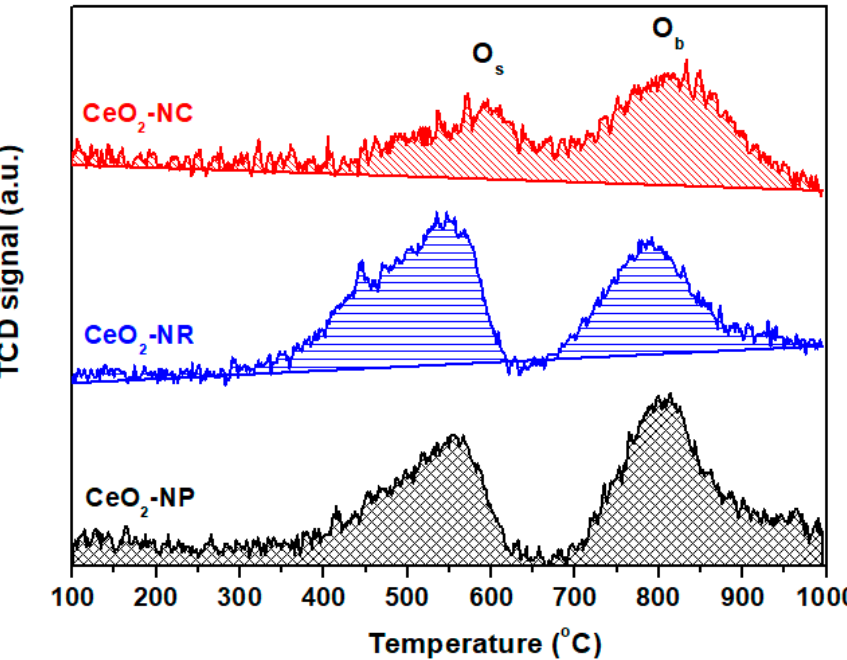
Figure 4. H 2 -TPR profiles of ceria nanoparticles.